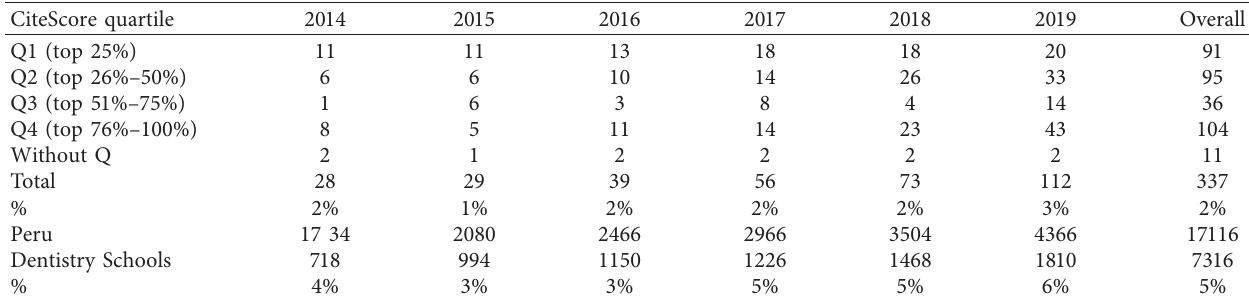
Table 3: Share of publications per journal quartile by CiteScore Percentile of all public and private Peruvian Faculties of Dentistry (2014–2019).